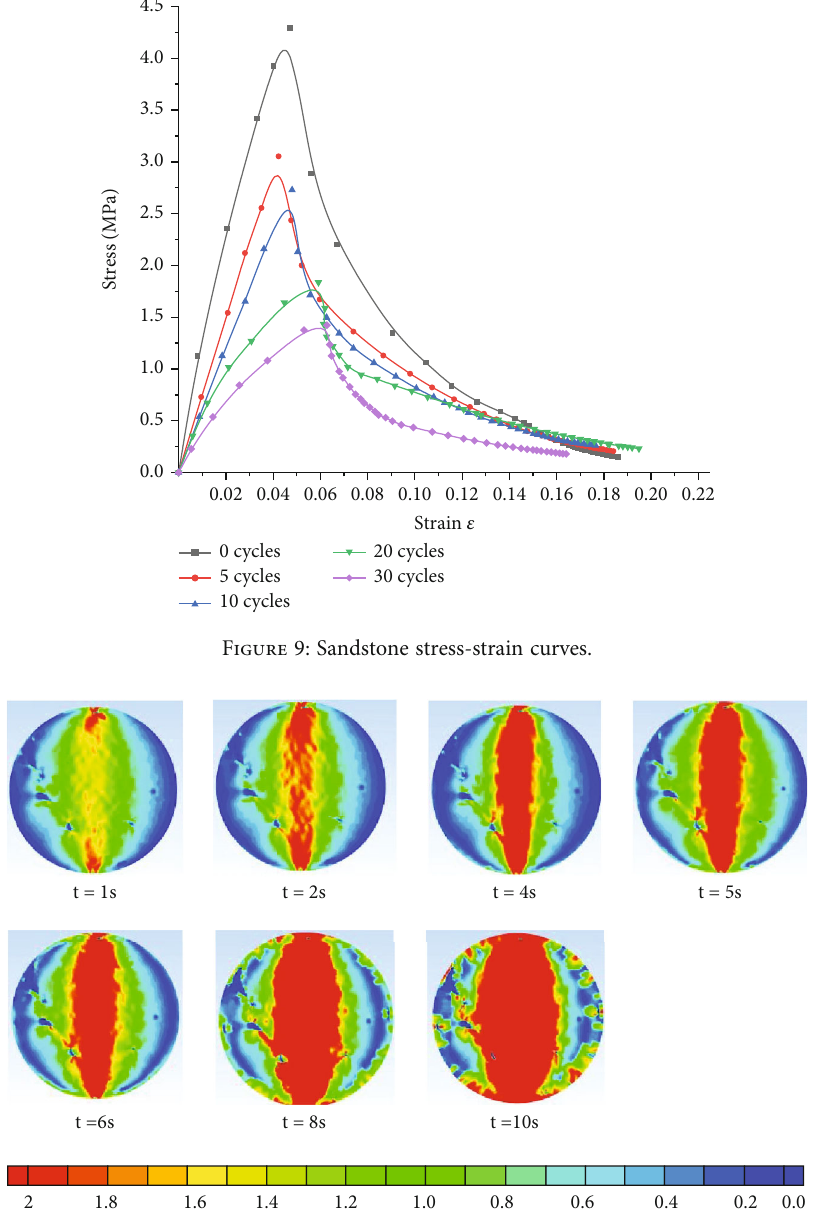
Figure 10: Fracture process map of sandstone containing natural damage under Brazilian